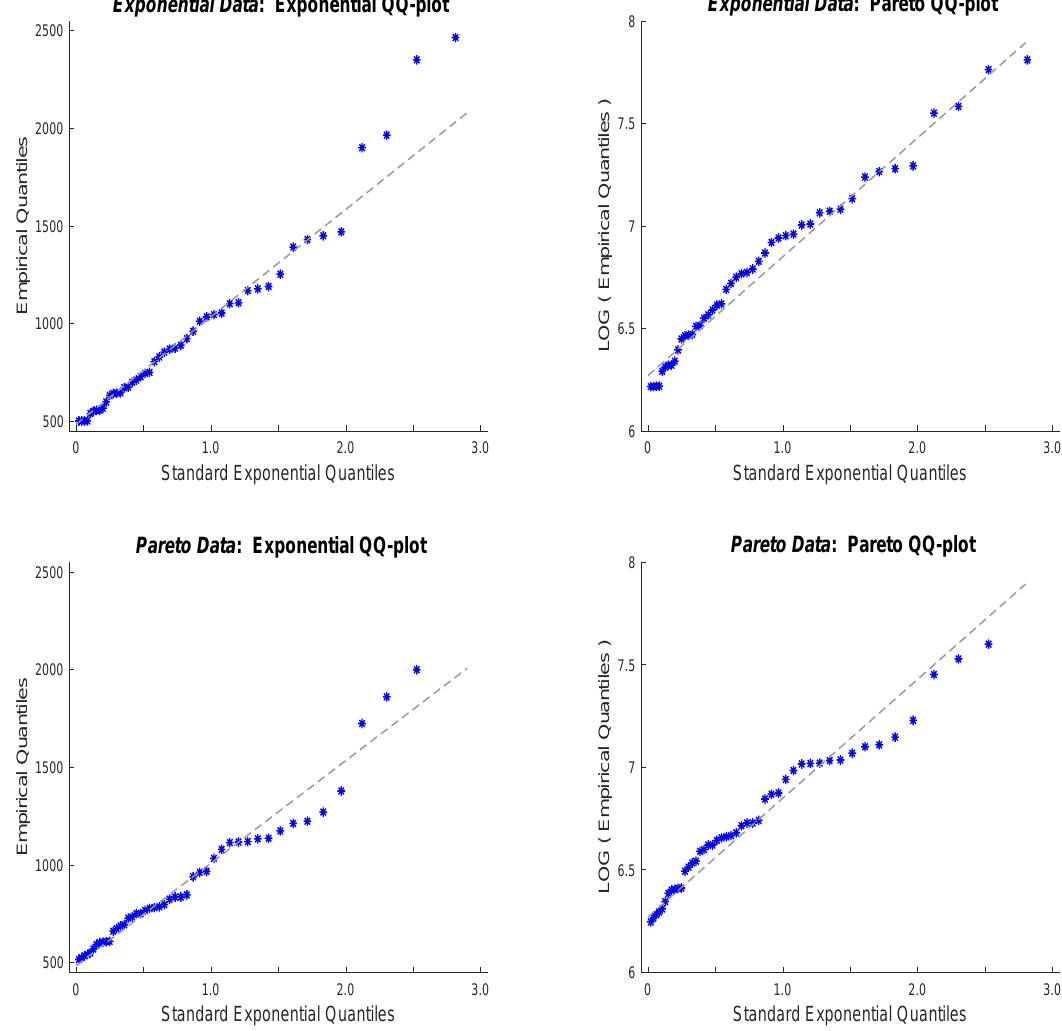
Figure 3. Exponential and Pareto quantile-quantile plots for the data sets of Table 1. The dashed line Figure 4.1. Exponential and Pareto quantile-quantile plots for the data sets of Table 4.1. represents the “best” fit line. Left column : y = 485 + 550 x ( top ) and y = 485 + 525 x (bottom). Right column : y = 6.27 + 0.58 x ( top and bottom The dashed line represents the “best” fit line. Left column: y = 485 + 550 x (top) and y = 485 + 525 x (bottom). Right column: y = 6 . 27 + 0 . 58 x (top and bottom).